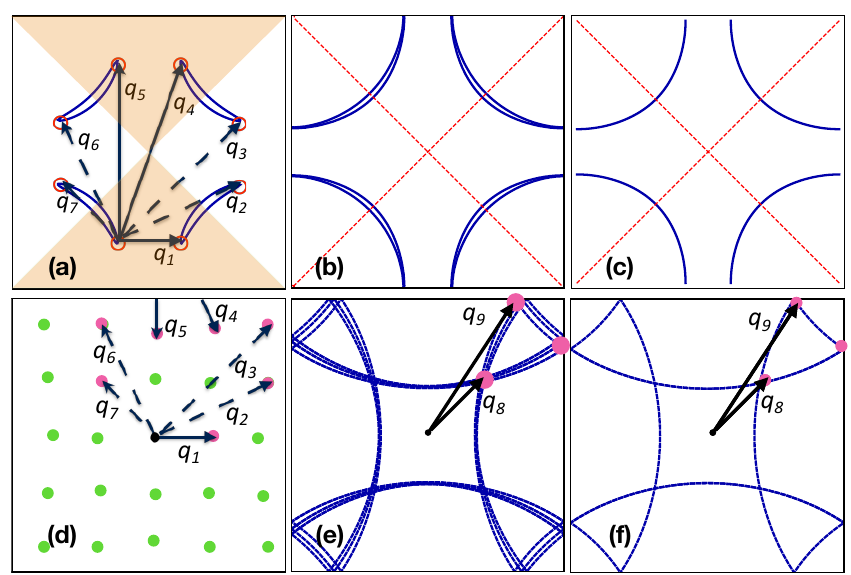
Figure 4: (a) The schematics of the banana-shaped CECs in the d -wave supercon- ducting state. The CECs at non-zero (b) finite energy ω ≳ ∆ < T < T ∗ or when T > T ∗ and (c) ω = 0. The scattering vectors q regime T c q are mainly responsible for the QPI patterns at high energy and high temperature. 9 (d), (e) and (f) indicate scattering vectors and corresponding